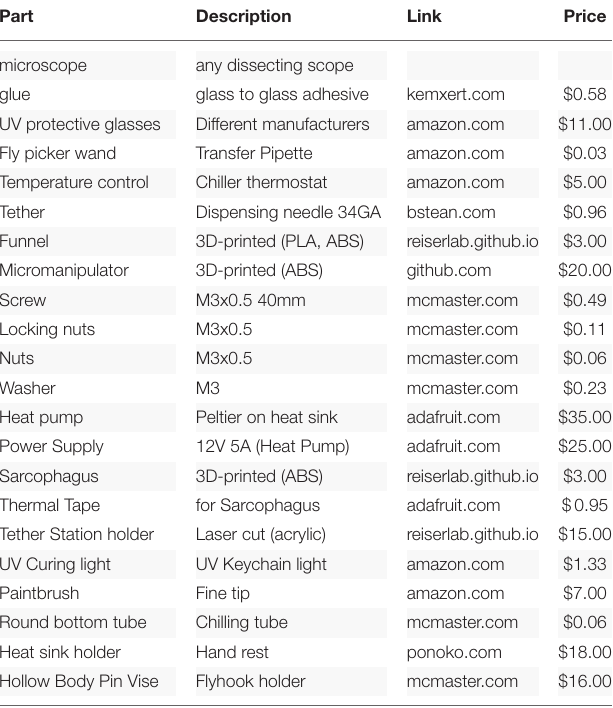
TABLE 2 | Suggestion for components in an inexpensive treadmill tethering